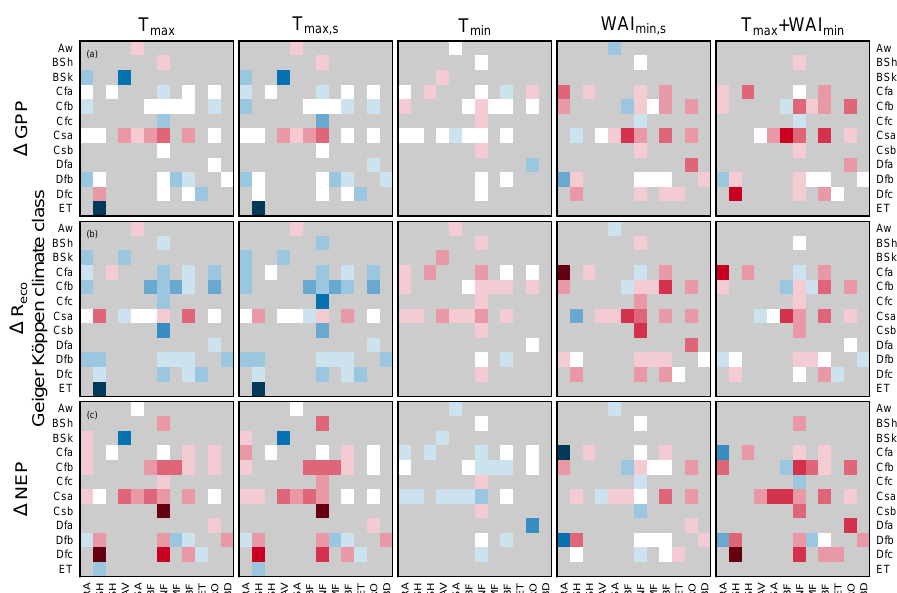
Figure 7. Z -transformed flux differences Differences between z -transformed CO 2 fluxes during extreme events and reference periods for the different extreme-event types and the different fluxes ( (cid:49)z = z extr − z ref ; see Eqs. 2 and 3 for details) of the different extreme-event types on GPP, R eco and NEP (rows 1–3) separated according to plant functional types (PFT) ( x axis in each plot; see Table A1 for the abbreviations used) and Geiger–Köppen climate class ( y axis in each plot; see Table A2 for the abbreviations used) for different types of extreme events (columns 1–5: heat (T max ), heat alone (T max, s ), cold (T min, s ), drought alone (WAI min, s ), and combined heat and drought (T max + WAI min )). Shades of red indicate reductions of different size in the respective fluxes; shades of blue indicate increases. Refer to Figs. 5 and 6 for a visualization or quantification of the actual magnitude of these